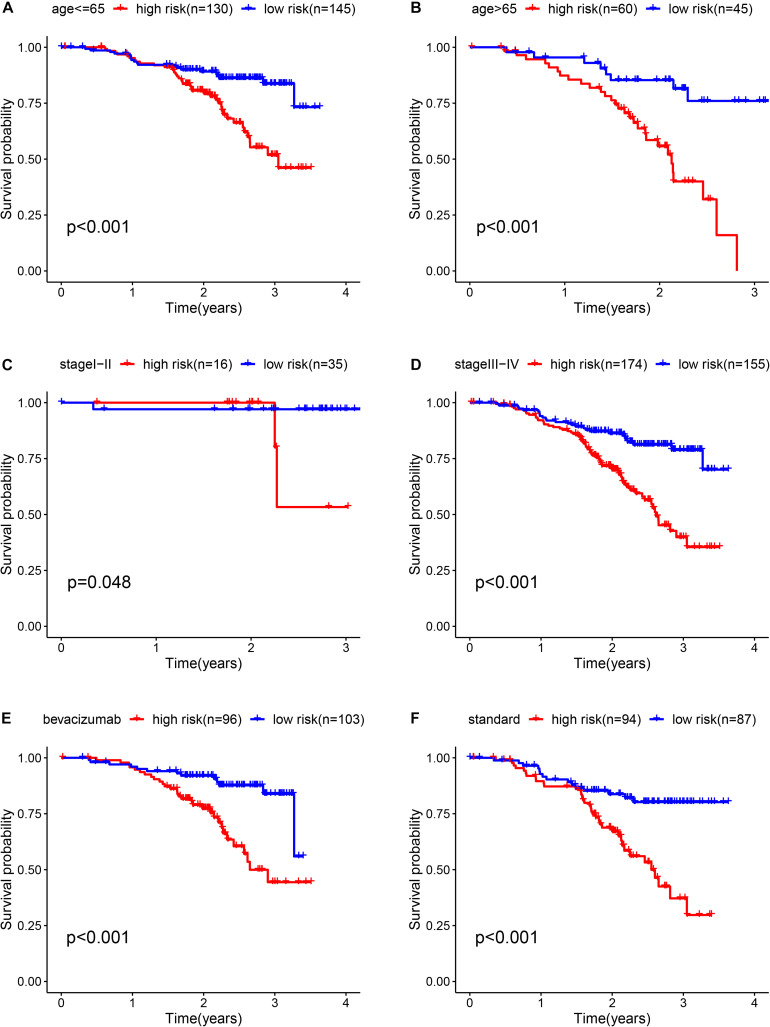
Kaplan-Meier curves for the prognostic value of the risk score signature for the patients grouped according to each clinical feature. (A) Age ≤ 65, (B) Age > 65, (C) stage I-II, (D) stage III-IV, (E) bevacizumab, and (F) Standard.